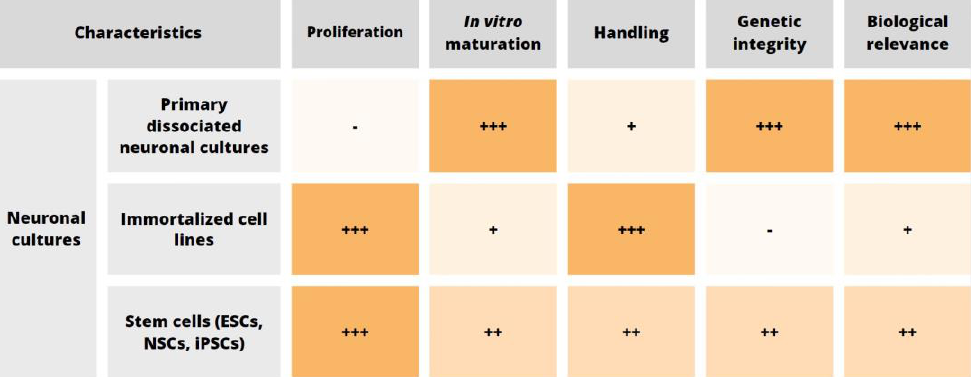
Figure 1. Neuronal in vitro models’ comparison. Neuronal cultures are classified according to their cell source (rows) and main characteristics (columns). The lack of proliferation in primary dissociated neuronal cultures refers to neurons and terminally differentiated glial cells (since glial cells also retain in vitro proliferation ability). Handling refers to ease of use in terms of culture preparation and maintenance procedures. - no; + low; ++ intermediate; +++ high level.